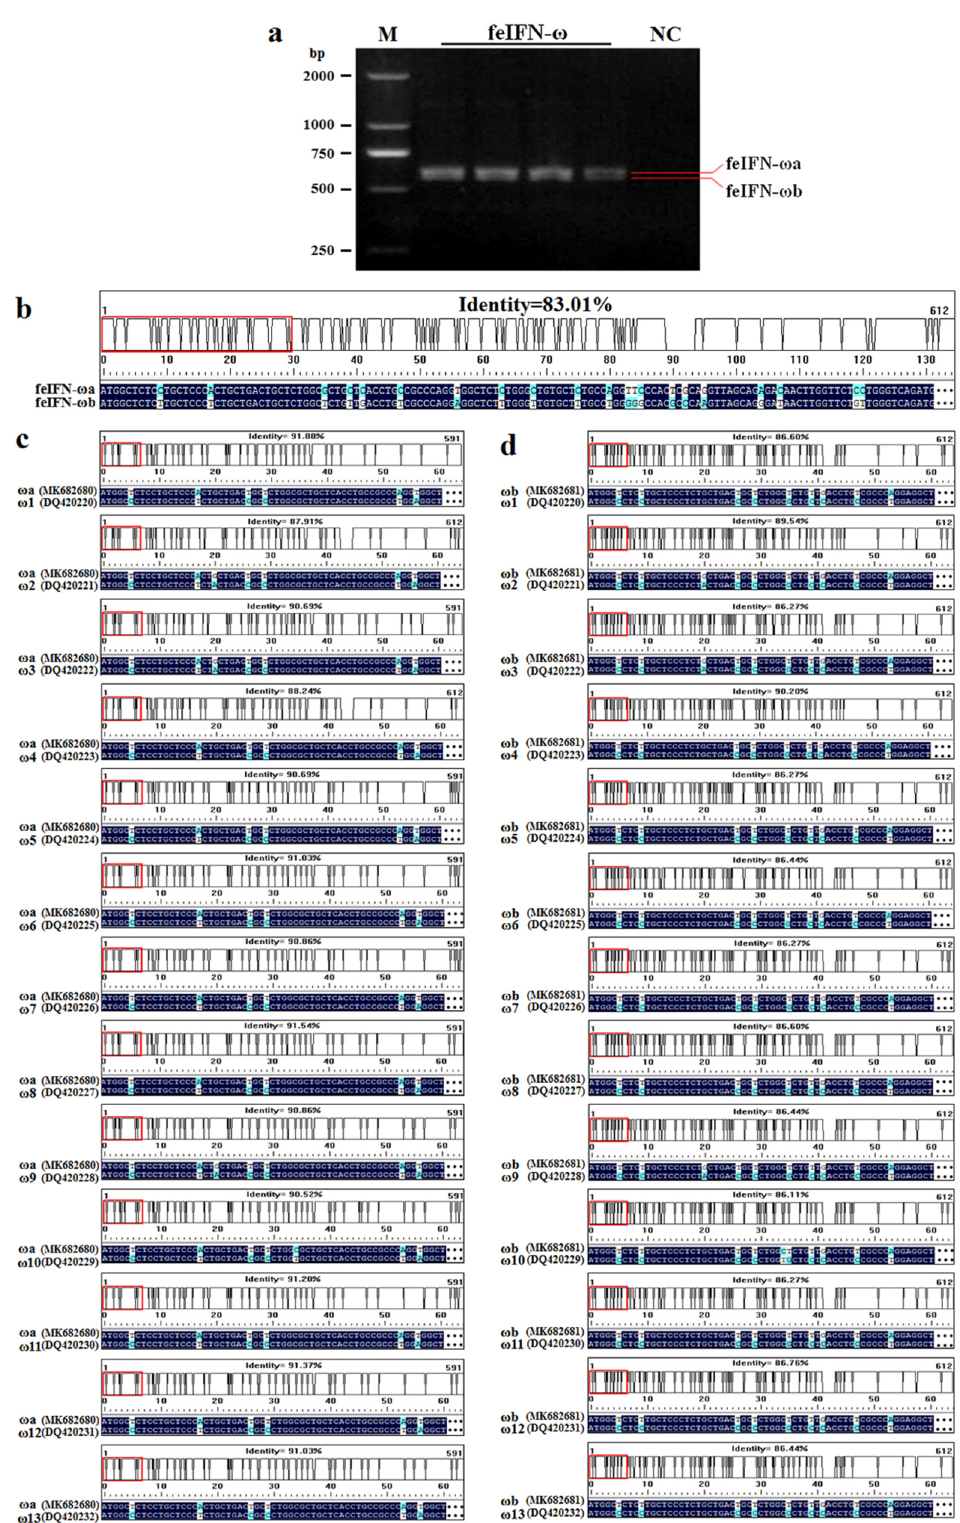
Figure 1. Identification of novel feline interferon omega (feIFN- ω ) genes in splenic lymphocytes of cats. ( a ). Two genes, encoding feIFN- ω a and feIFN- ω b, were amplified by RT-PCR. M: DNA marker; NC: negative control. ( b ). Nucleotide sequence homology between the feIFN- ω a and feIFN- ω b genes. ( c ). Nucleotide sequence homology between the feIFN- ω a gene and the 13 known subtypes of feIFN- ω genes published in the GenBank. ( d ). Nucleotide sequence homology between the feIFN- ω b gene and the 13 known subtypes of feIFN- ω genes. Red box means comparison length unit.